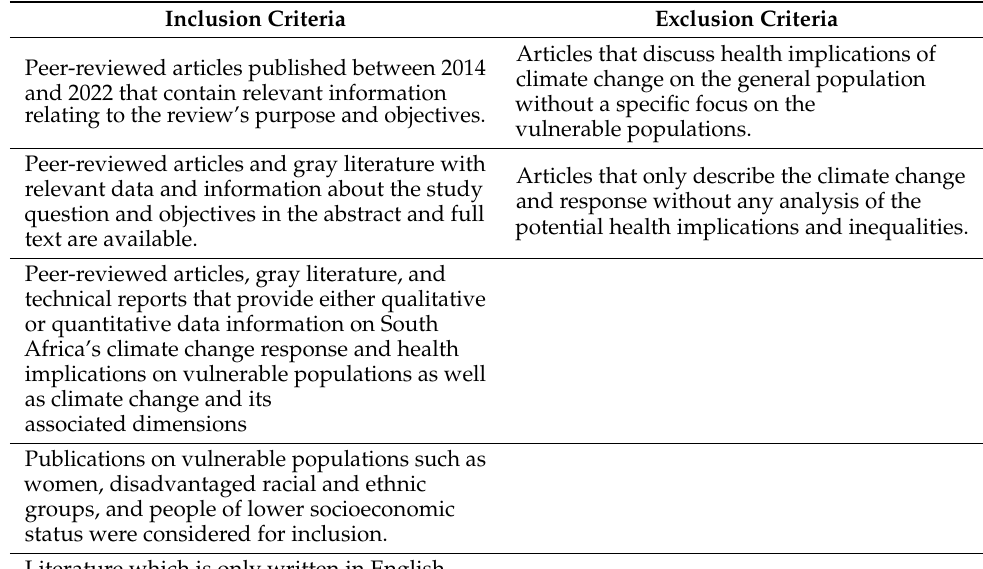
Table 1. Inclusion and exclusion criteria of the